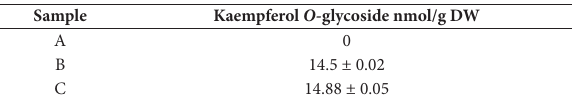
Table 2. Concentration of kaempferol O -glycoside (nmol/g DW) in suspension cultures of A. vesicarius ssp. carniolicus; A – plant cells grown on G48 medium, non-treated with kae- mpferol (control); B – plant cells grown on G48 medium, sup- plemented with 2 mg/mL kaempferol; C – G48 medium, supple- mented with 4 mg/mL kaempferol.